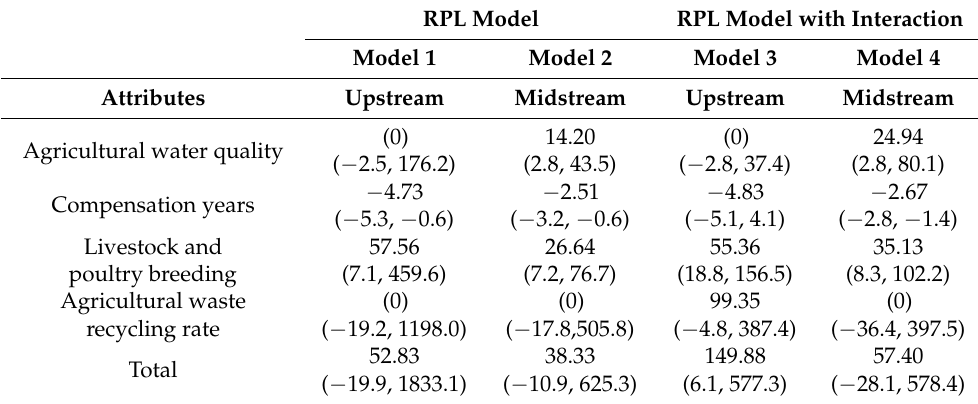
Table 5. WTA estimates and 95% confidence interval for each